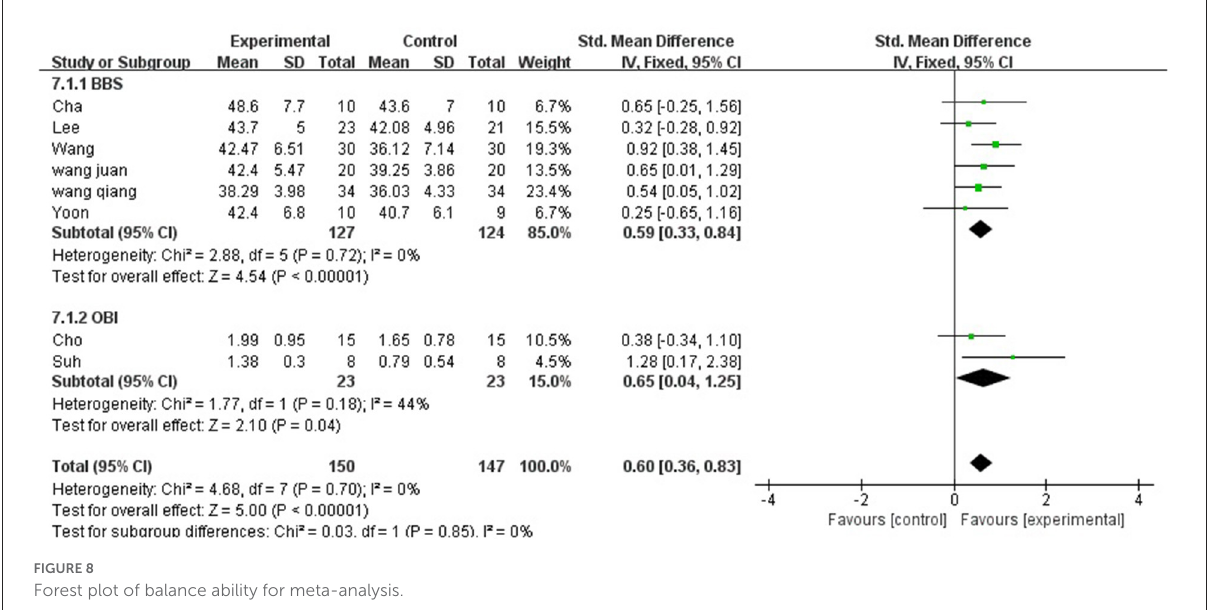
FIGURE8 Forest plot of balance ability for meta-analysis.